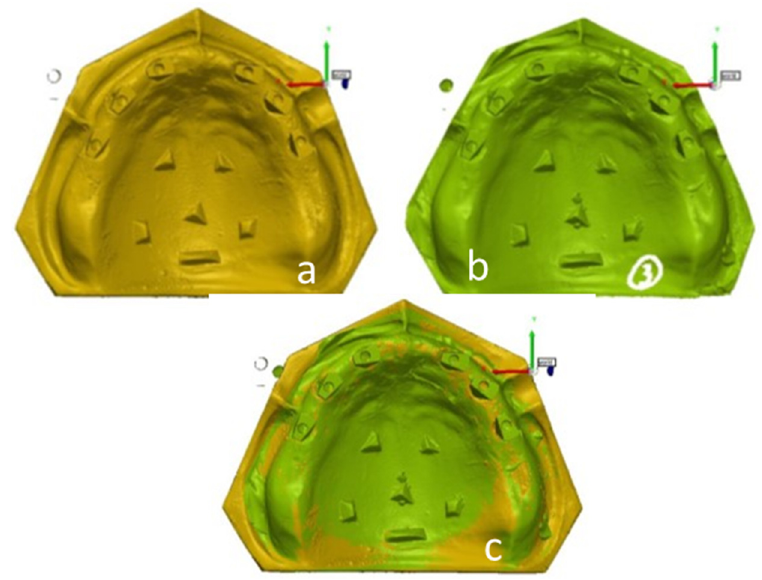
Figure 3. ( a )—master model scan; ( b )—study group scan; ( c )—master model scan digitally over- Figure 3. a —master model scan; b —study group scan; c —master model scan digitally overlapped lapped with study group scan. with study group scan .